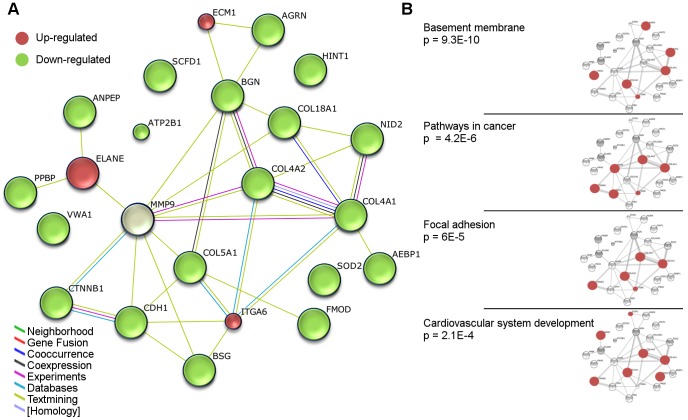
Network of differential level proteins in cholesteatoma with associations to connective tissue.A. The top scoring, automatically-synthesized network of related proteins in IPA: Connective Tissue Development and Function, Embryonic Development, Organ Developmentive tissue.d proteins: Group B proteins.d EACS.holesteatoma a STRING. All proteins, except for MMP9, showed the same expression direction comparing cholesteatoma with tympanic membrane and EACS, respectively. Protein level differences meeting the group A or B criteria were detected in at least one of the two comparisons. 41 interactions (7.95 expected) were identified between the 23 proteins, network p value = 1.11e-16. B. Some of the top scoring significant associations of the network with: GO Biological Processes, GO Cellular Components, and KEGG Pathways; ordered by p value.